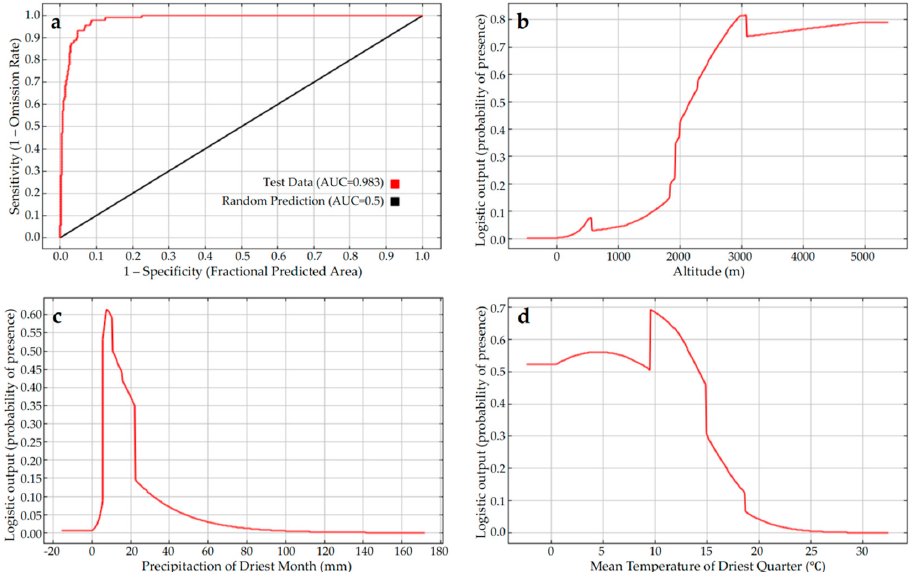
Figure 3. Curves showing the accuracy of the model. Curve of AUC for ( a ) environmental variables with the greatest contribution in the modeling of the potential distribution of Cuphea aequipetala Cav.; ( b ) altitude; ( c ) precipitation of the driest period; and ( d ) average temperature of the driest